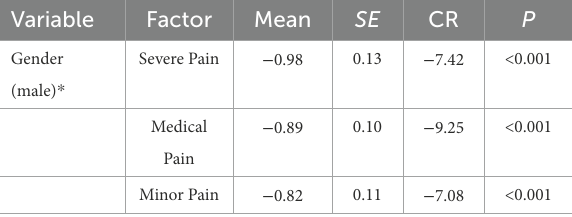
TABLE 7 Gender latent mean values.